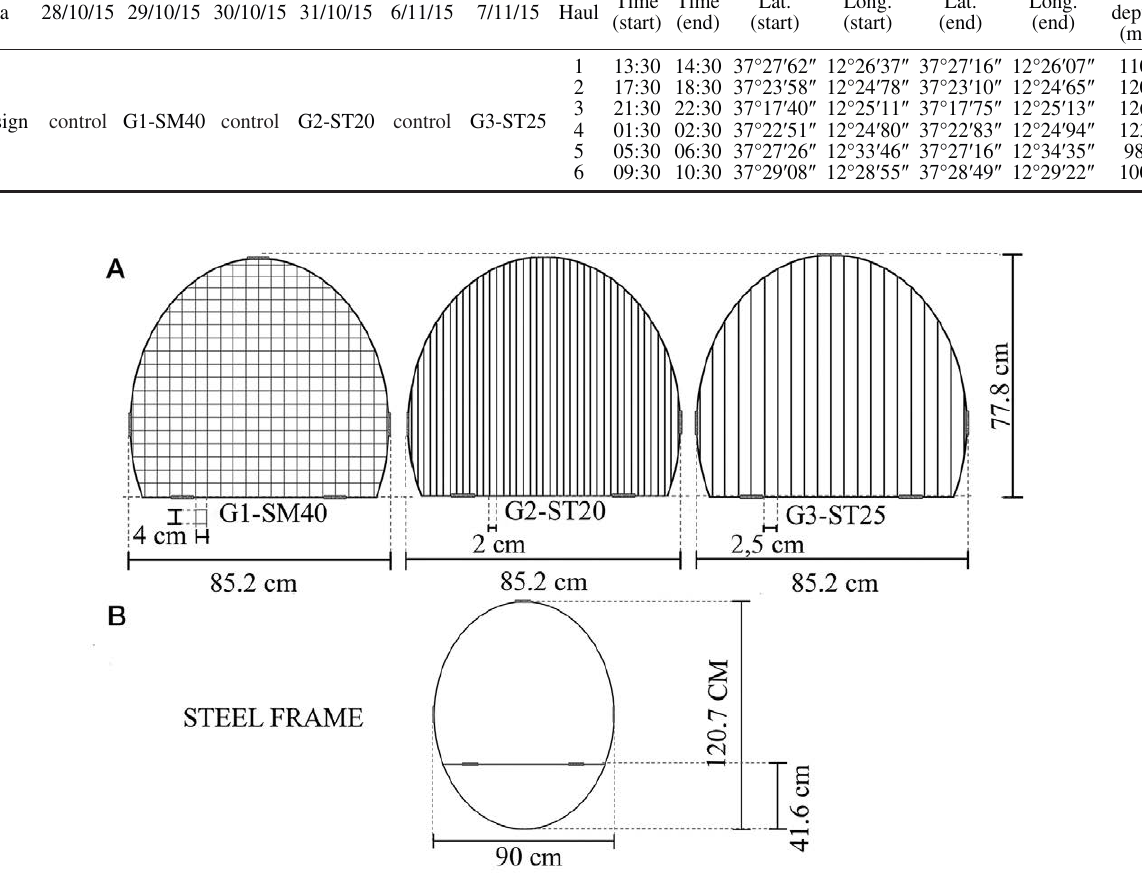
Fig. 2. – The designed sorting grid (JTED) with two parts: A, interchangeable grids in a steel frame; B, the fixed steel